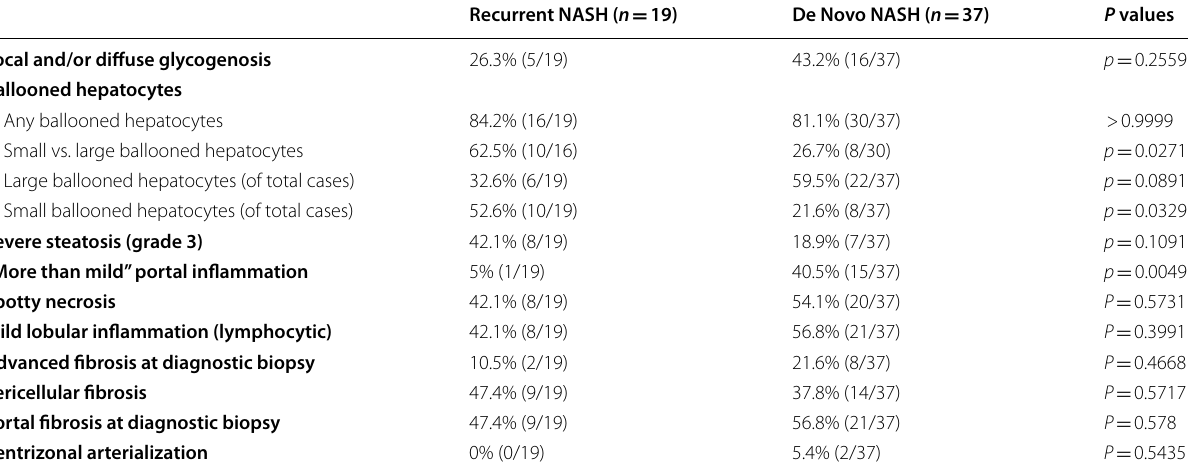
Table 4 Pathologic Characteristics of Recurrent versus De Novo NASH